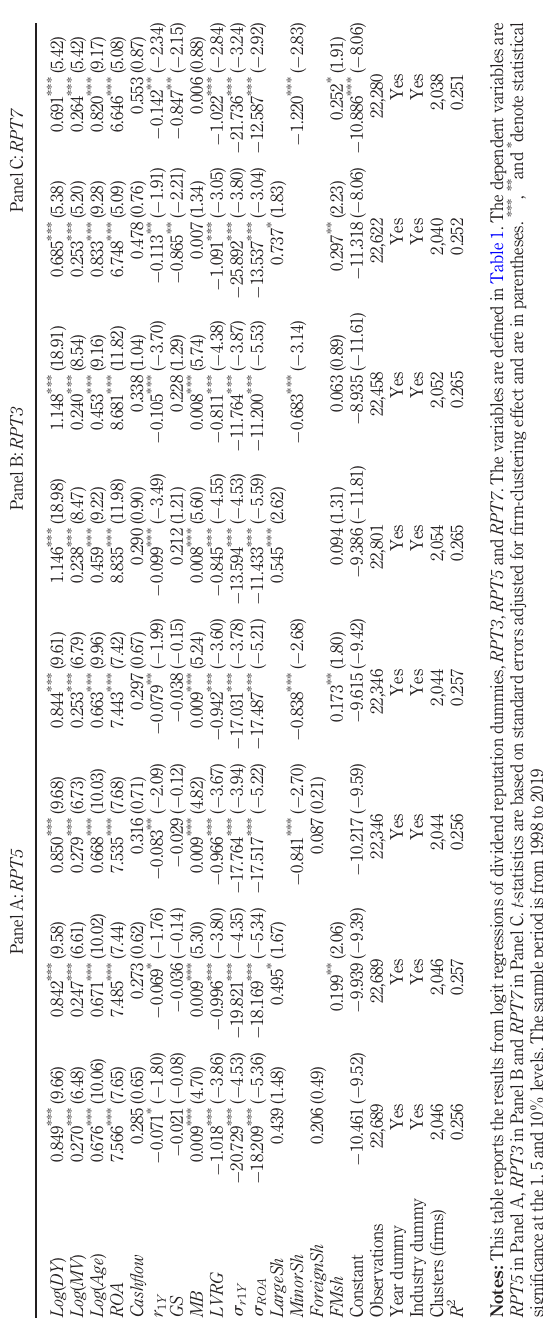
Table 5. Determinants of reputation building: Logit